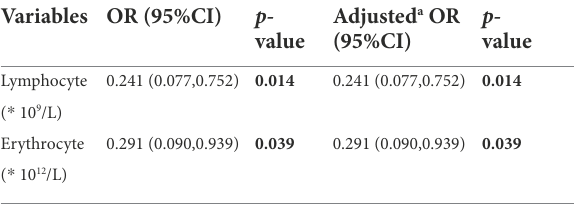
WMH, White matter hyperintensities. a Adjusting for age and gender confounders. The bold value means p